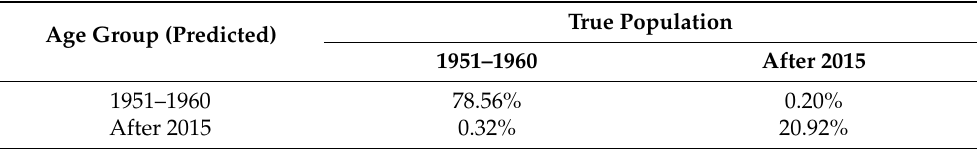
Table 5. Classification accuracy for the bivariate